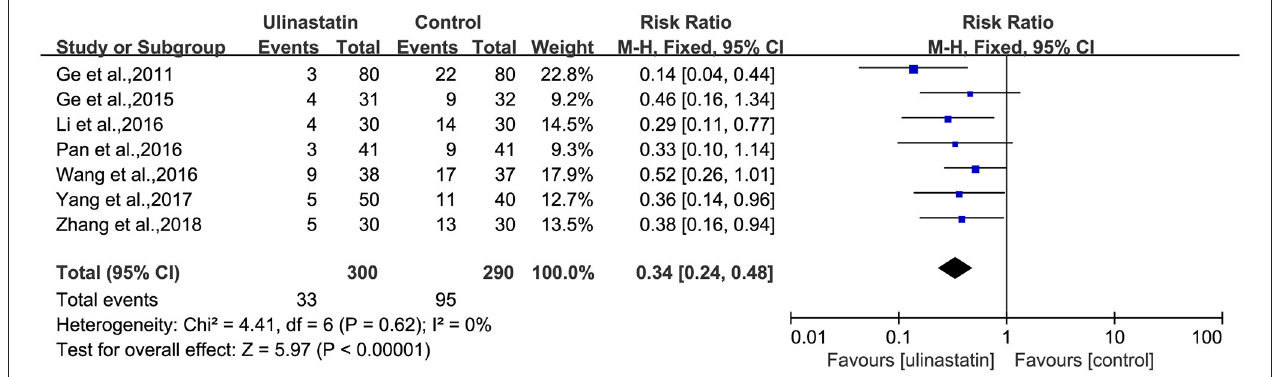
FIGURE 4 | Forest plot: Meta-analysis and pooled risk ratio (RR) of the effect of ulinastatin on postoperative cognitive dysfunction (POCD) after removing three articles with publication